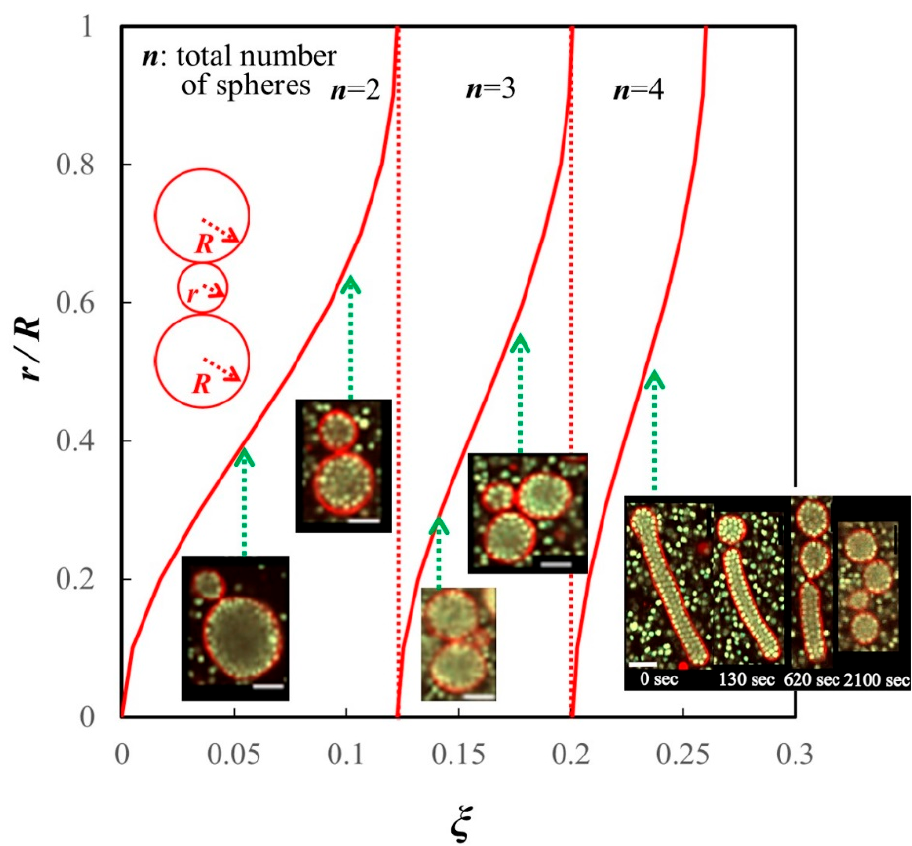
Figure 2. Geometrical relationship between the ratio of radii r/R and ξ for the divided vesicles that encapsulated polystyrene beads. R , the radius of large spheres when n = 2, 3, and 4; r , radius of a single small sphere. Calculated results (red curves) were in good agreement with the experimental data (micrographs). The right micrograph shows a typical shape deformation pathway from a tubular vesicle to multispheres when n = 4. Scale bars, 5 µ m. At n ≥ 3, vesicles divided into one small sphere and other ( n − 1) spheres that all had the same radius. This figure is a revision of Figures 6 and 7 in [16].